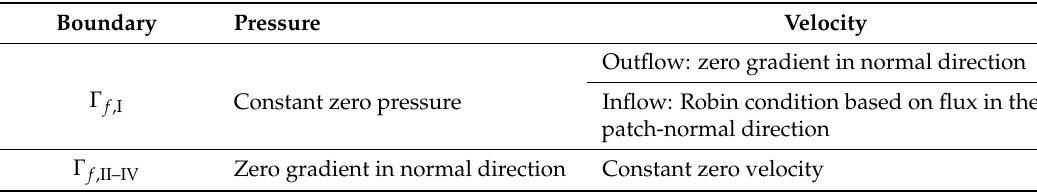
Figure 3. Drop test of rigid cylinder: ( a ) Schematic representation of drop test; ( b ) Section of the fluid mesh (mesh02). Table 1. Boundary conditions in fluid domain.